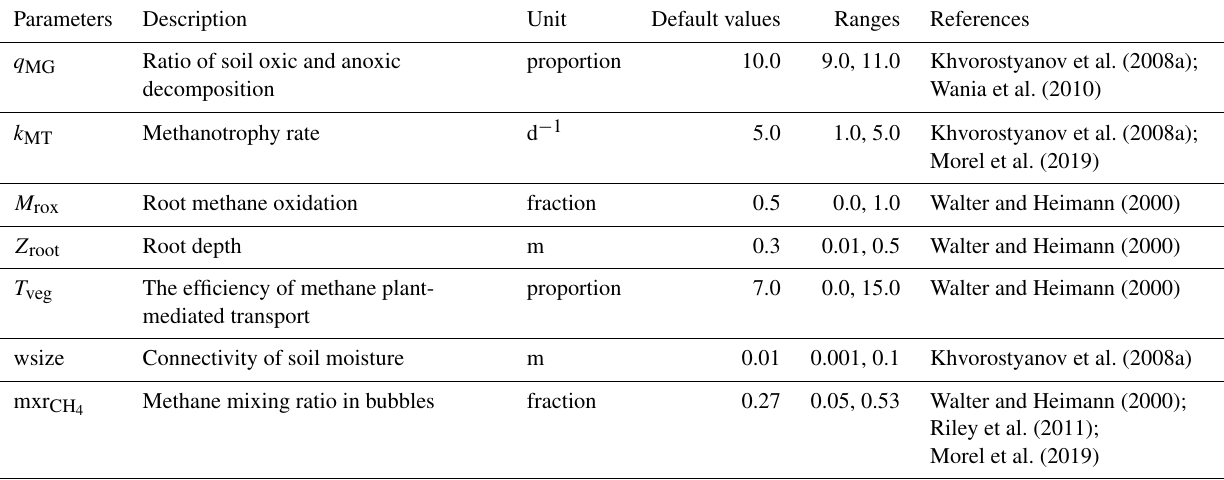
Table 3. List of parameters driving the methane production, oxidation, and transport scheme in ORCHIDEE-PCH 4 .